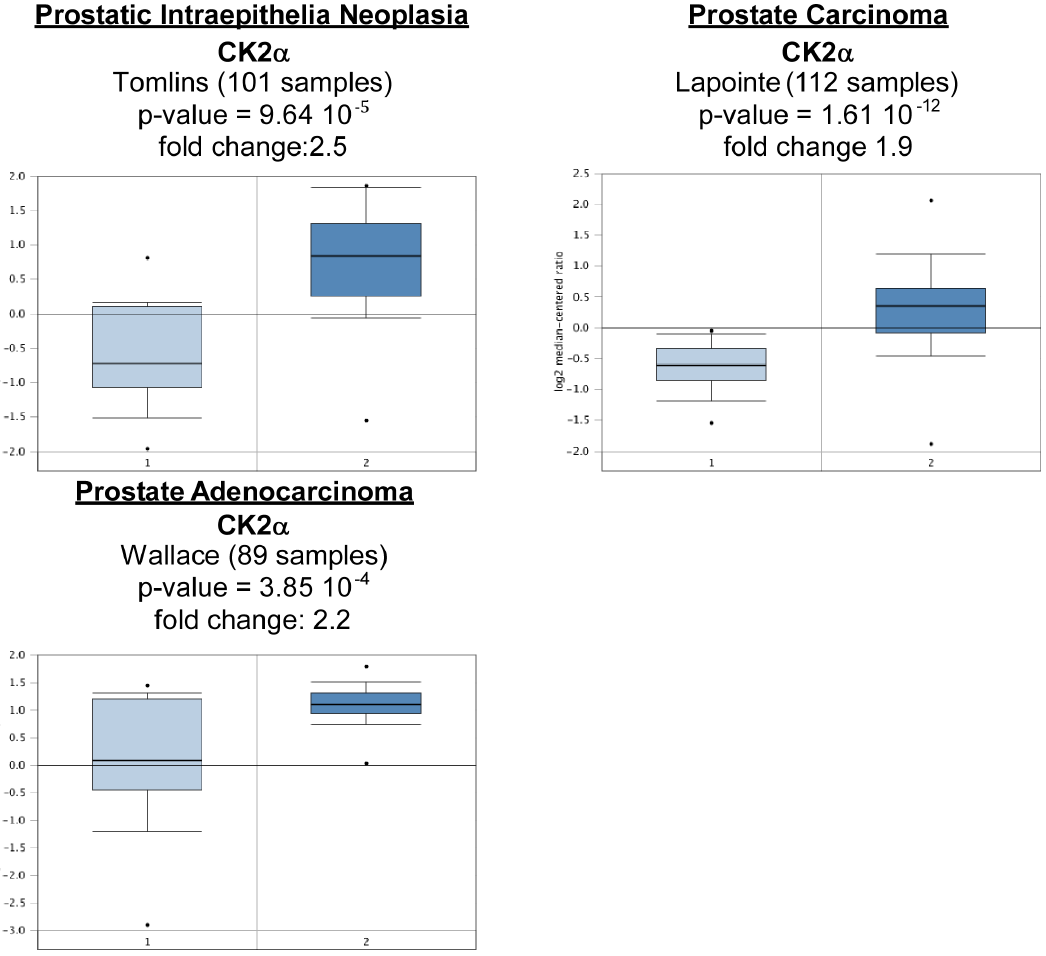
Fig. 9. CK2 a gene analysis in prostate cancer (Oncomine database). Box plots derived from gene expression data in Oncomine comparing expression of CK2 a gene in normal (left plot) and various types of prostate cancer tissue (right plot). Oncomine box plots were retrieved from various types of prostate cancer.